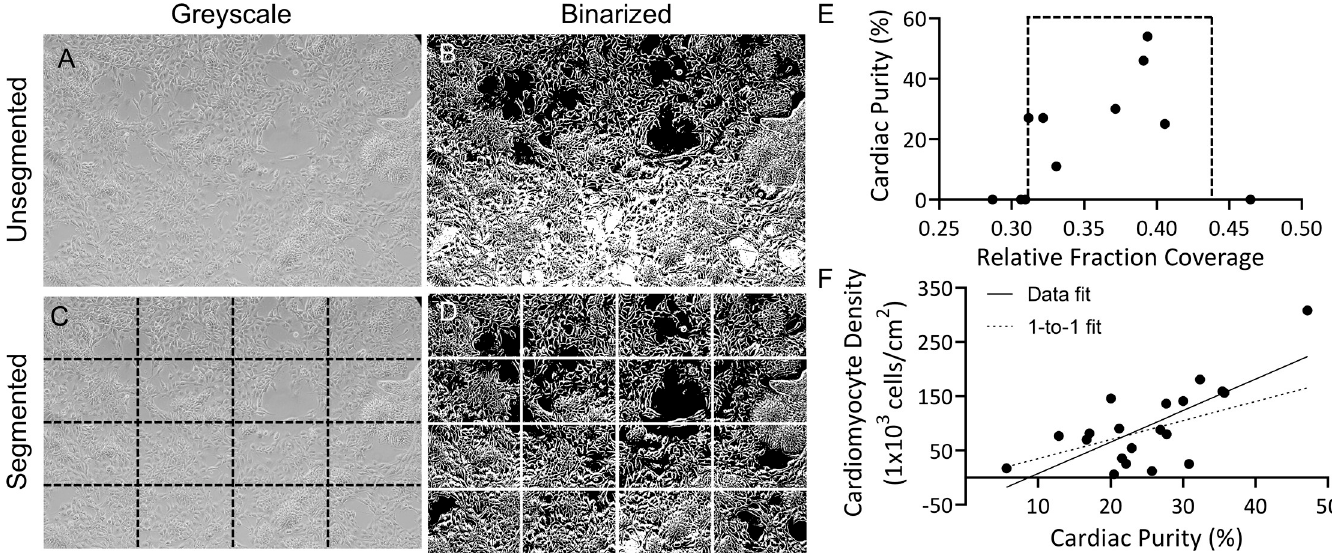
Fig 3. Segmented thresholding shows range of plate coverage for cardiomyocyte differentiation using 6 μ M Chiron. (A) Brightfield image of Gibco hiPSCs (GiPSCs) at day 0 of differentiation. (B) Threshold of image without prior segmentation. (C) Segmented image, indicated by dashed black lines, and (D) reconstructed image after thresholding of segments. (E) GiPSC-cardiomyocyte purity plotted as a function of relative fraction coverage at day 0, dashed box indicated range of plate coverage in which differentiation runs produced cardiomyocytes. N = 11 independent differentiation runs; data points represent single differentiation run outcomes. (F) HiPSC-cardiomyocyte density per cm 2 of growth area as a function of cardiac purity was fit with a linear regression. Data points represent single differentiation run outcomes (n = 20); solid line: linear regression, R 2 = 0.51; dashed line: linear regression assuming 1-to-1 relationship between cardiomyocyte purity and density. https://doi.org/10.1371/journal.pone.0230001.g003 protocol (Fig 4) [14] to fit our differentiation pipeline, to attain hiPSC-cardiomyocyte popula- tions of > 80% purity (Fig 4B).